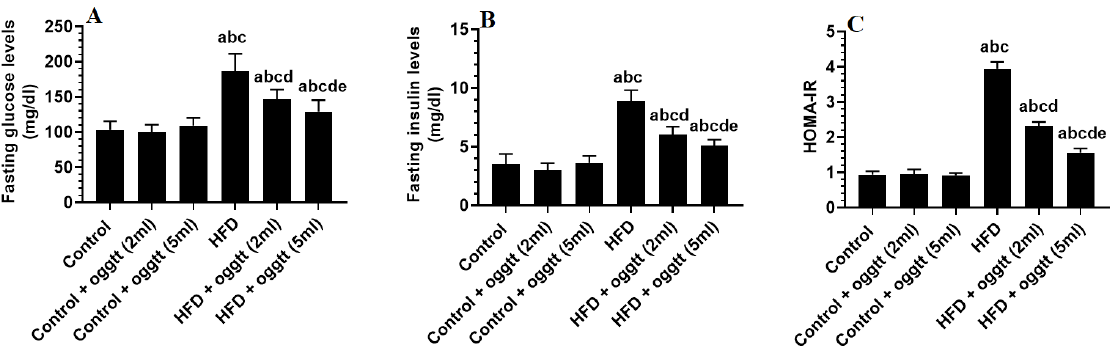
Figure 1. Oggtt milk reduces fasting glucose ( A ) and insulin levels ( B ) as well as values of homeostasis model assessment of insulin resistance index (HOMA-IR) ( C ) in high-fat diet (HFD)-fed-rats in a dose-dependent manner. Data were expressed as means ± SD for n = 8 rats/group. a, vs. control; b, vs. control + oggtt (2 mL); c, vs. control + oggtt (5 mL); d, vs. HFD; and e, vs. HFD + oggt (2 mL).